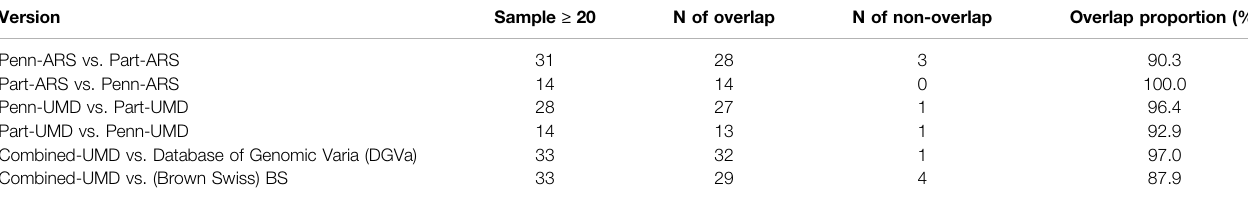
TABLE 4 | Cross-validation results of CNVR with a sample size greater than 20 in different methods.